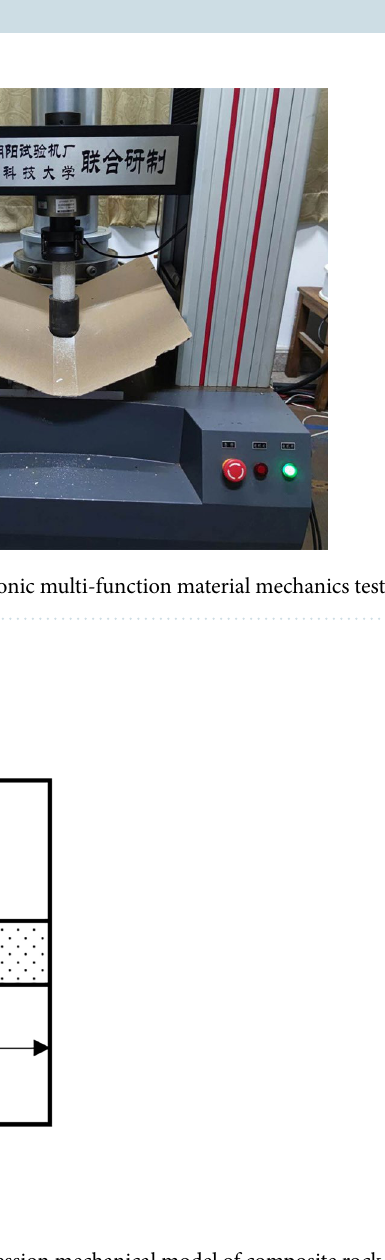
Figure 4. Uniaxial compression mechanical model of composite rock mass specimen with a weak horizontal